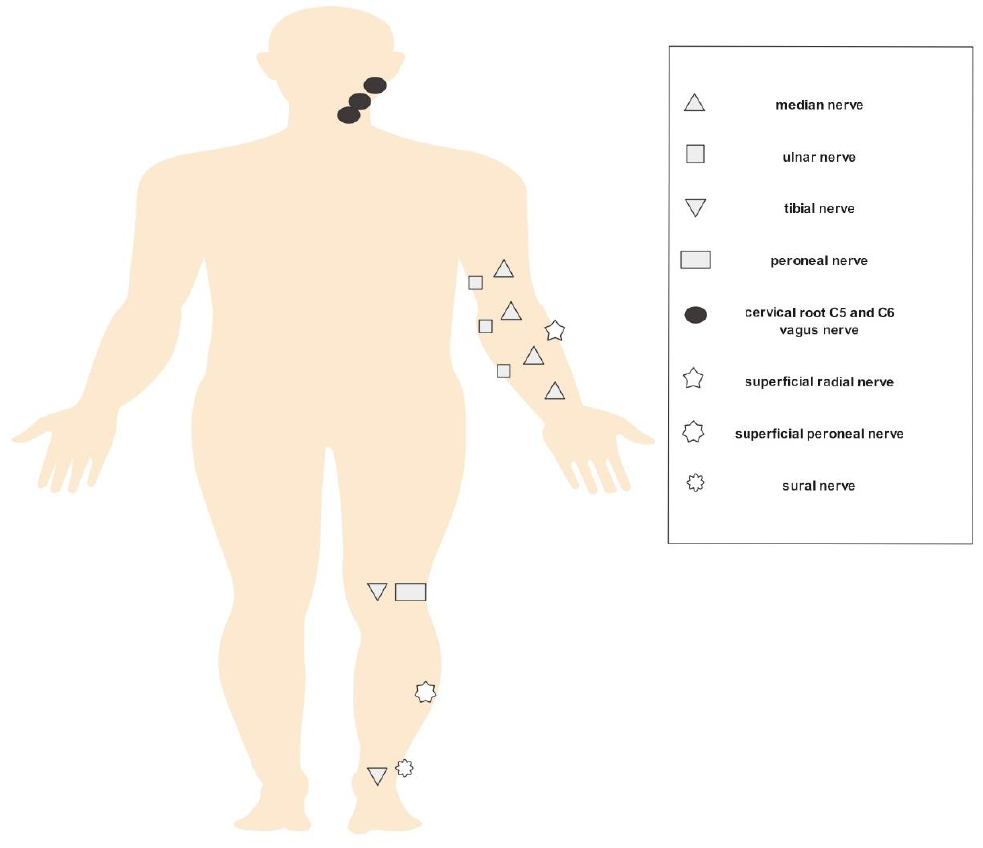
Figure 1. HRUS (high-resolution nerve ultrasound) measurement points.